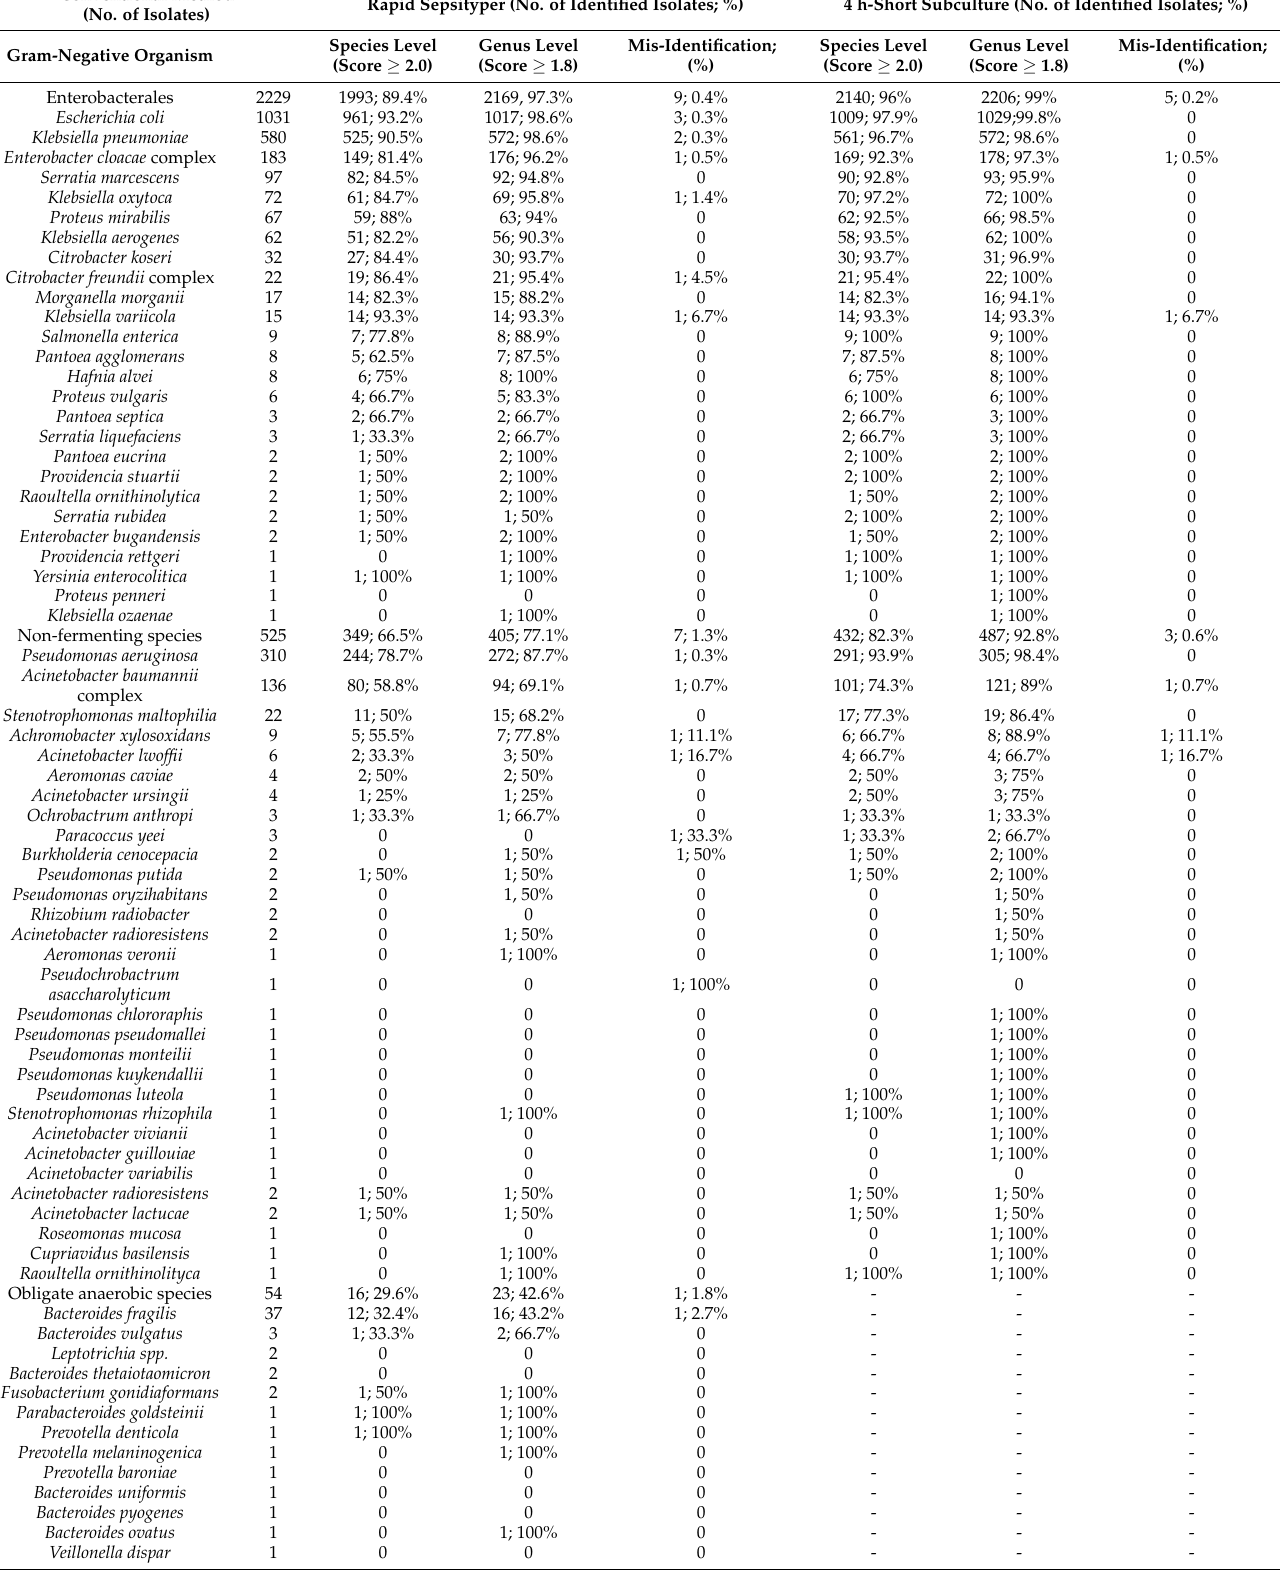
Table 1. MALDI-TOF MS identification of Gram-negative isolates from monomicrobial positive blood cultures using Rapid Sepsityper and 4-h short-subculture